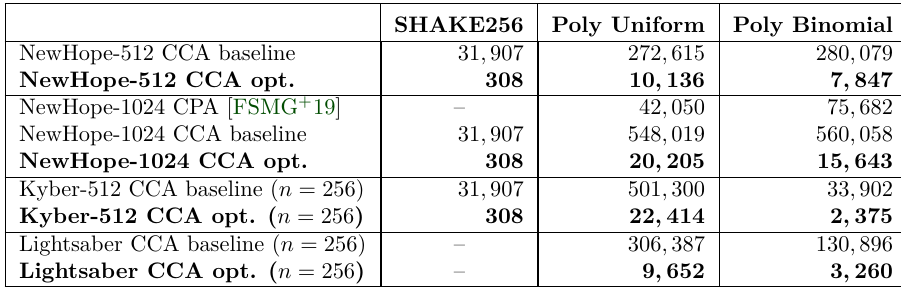
Table 4: Cycle count of SHAKE256 (32 byte input/output length), uniform sampling, and binomial sampling. Kyber and Saber have for all security strengths the same polynomial length. The results for Poly Uniform and Poly Binomial are given with respect to generating one